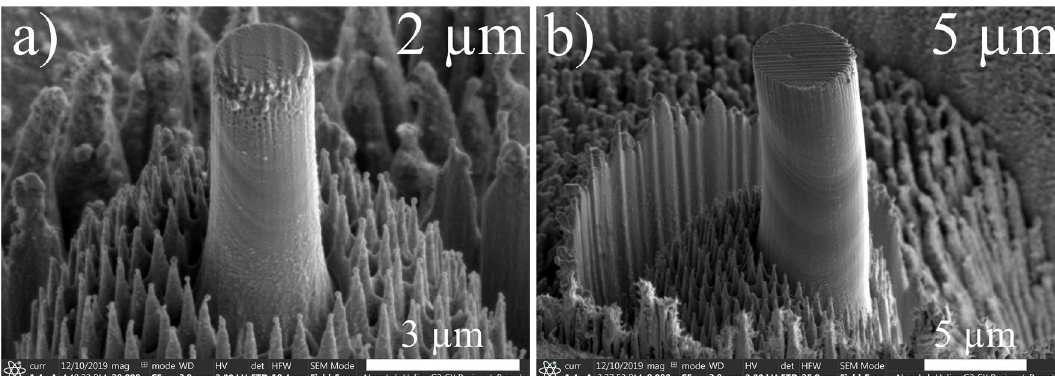
Figure 5. InSb micro-pillars with a diameter of 2 µm and 5 µm after deformation and taken with a tilt of 52°. The sides presented here are the same for both SEM images with respect to the sample orientation.